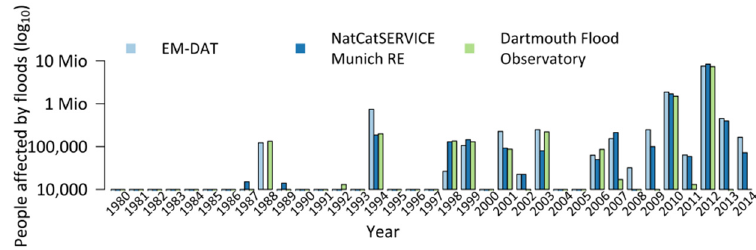
Figure 8. People affected by catastrophic floods per year in the Niger River Basin from 1980 to 2014 for three different data sources. Note that the scale of the y-axis is